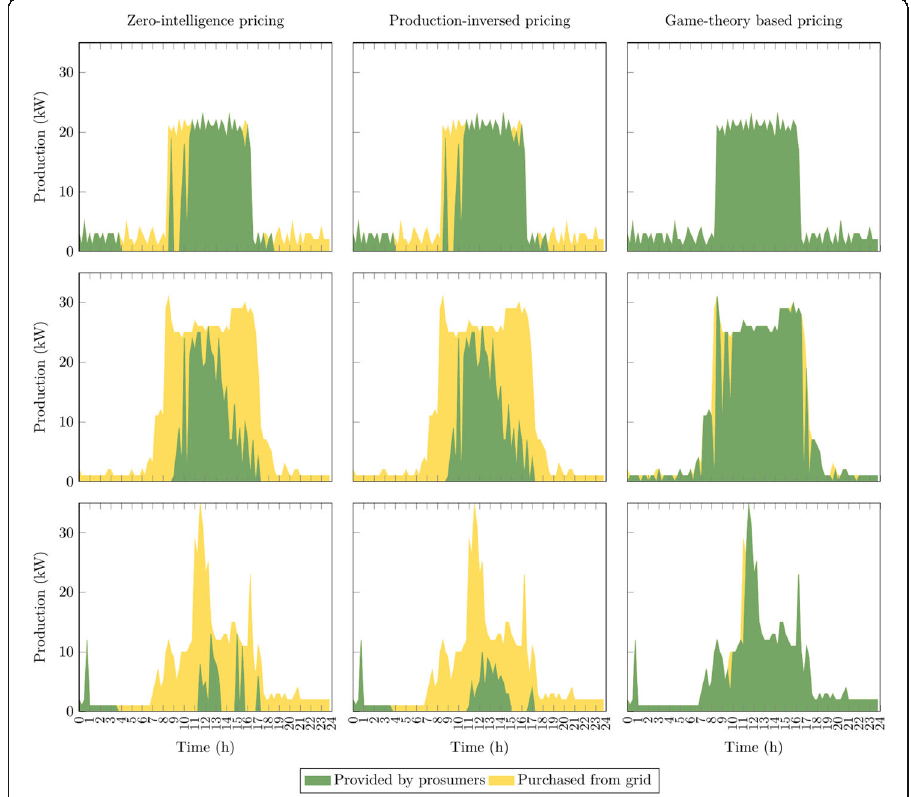
Fig. 5 Electricity settlements of houses under each pricing strategy. Rows from top to bottom correspond to House 0 , House 1 , and House 2 . Energy supplied by local generation is marked in green, while the supply from the grid and battery is marked in